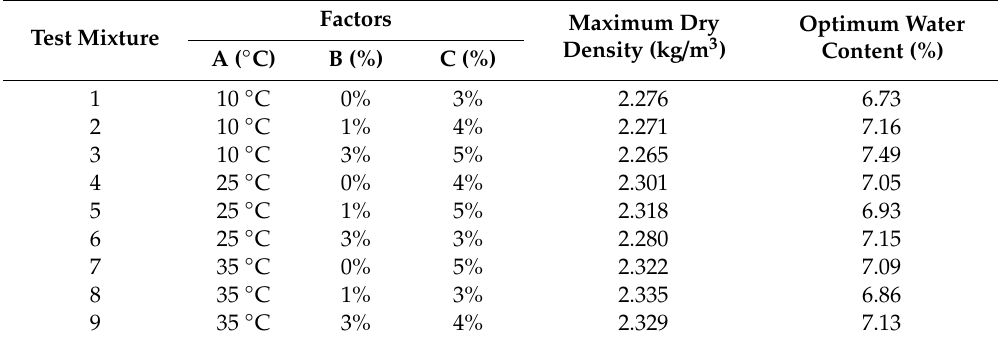
Table 9. The results for orthogonal test.